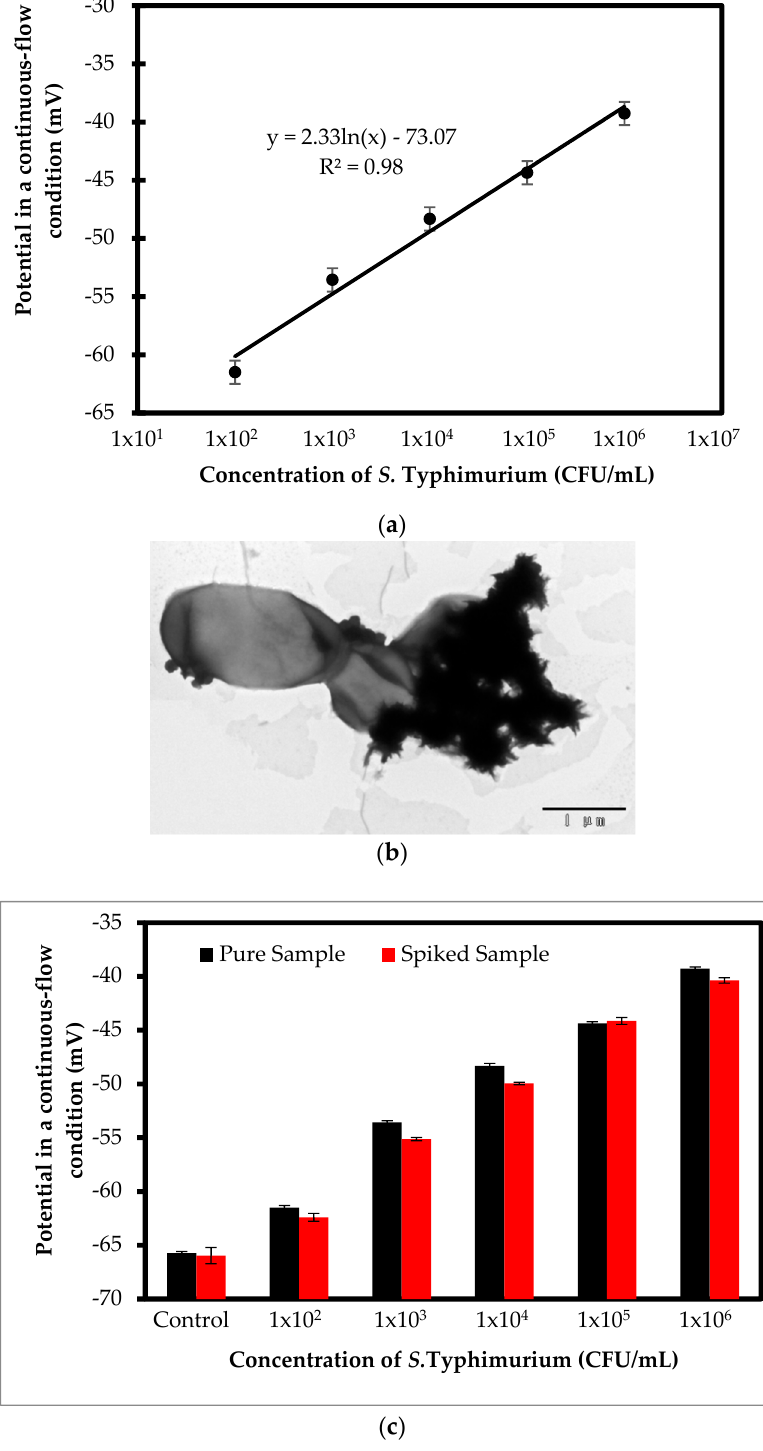
Figure 4. ( a ) Calibration curve of the proposed assay ( N = 3); ( b ) TEM image of the nanoflower conjugated bacteria; ( c ) Detection of the spiked chicken samples containing the S. Typhimurium cells with the concentrations from 1.0 × 10 2 to 1.0 × 10 6 CFU/mL ( N = 3).